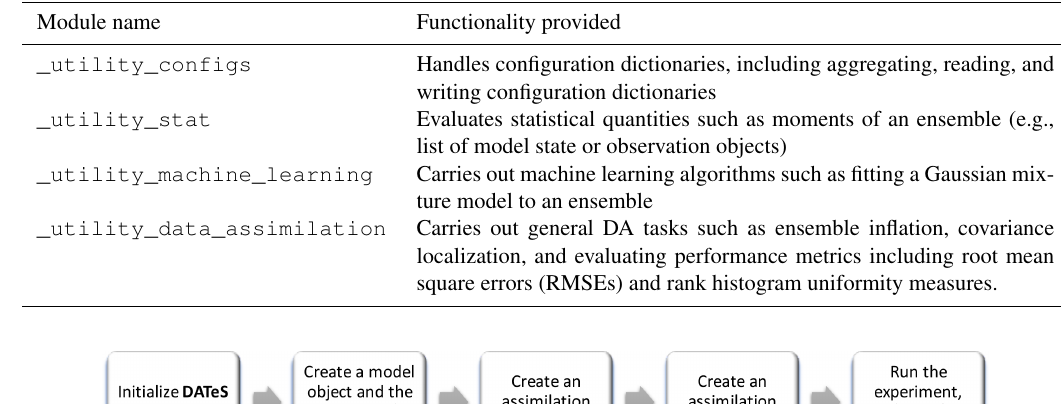
Table 4. A sample of the modules wrapped by the main utility module dates_utility .